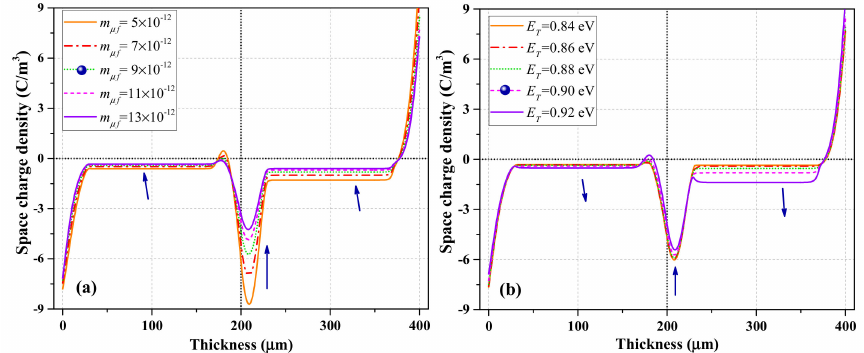
Figure 7. Simulation results of charge after polarization for 1800 s of PET–PET samples. Influence of ( a ) fast mobility m uf and ( b ) bulk trap depth E T for electrons and